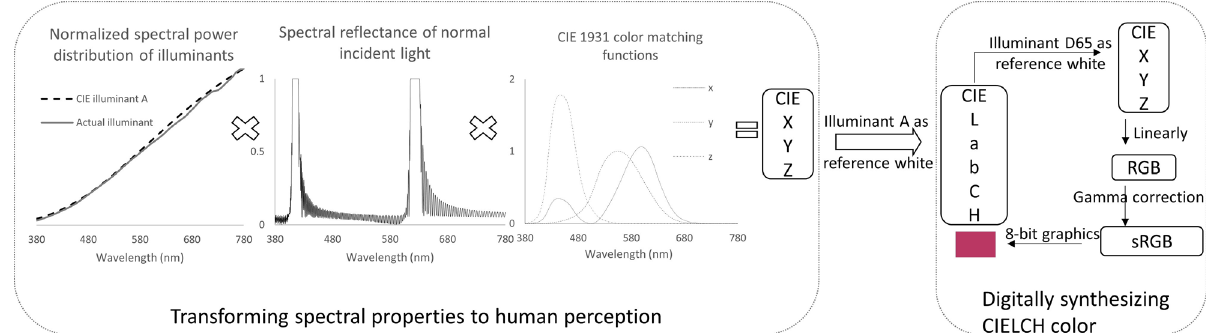
Figure 5. Procedures of color calculation (left) and digital synthetization